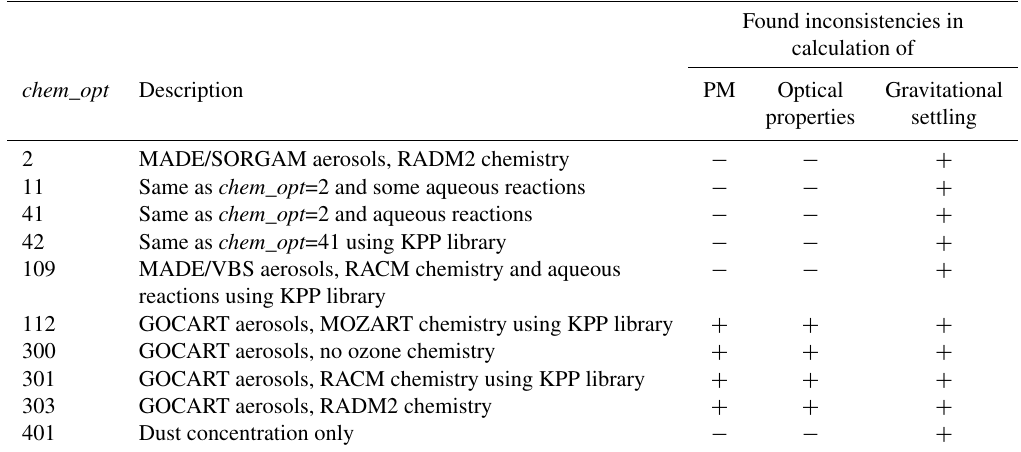
Found inconsistencies in